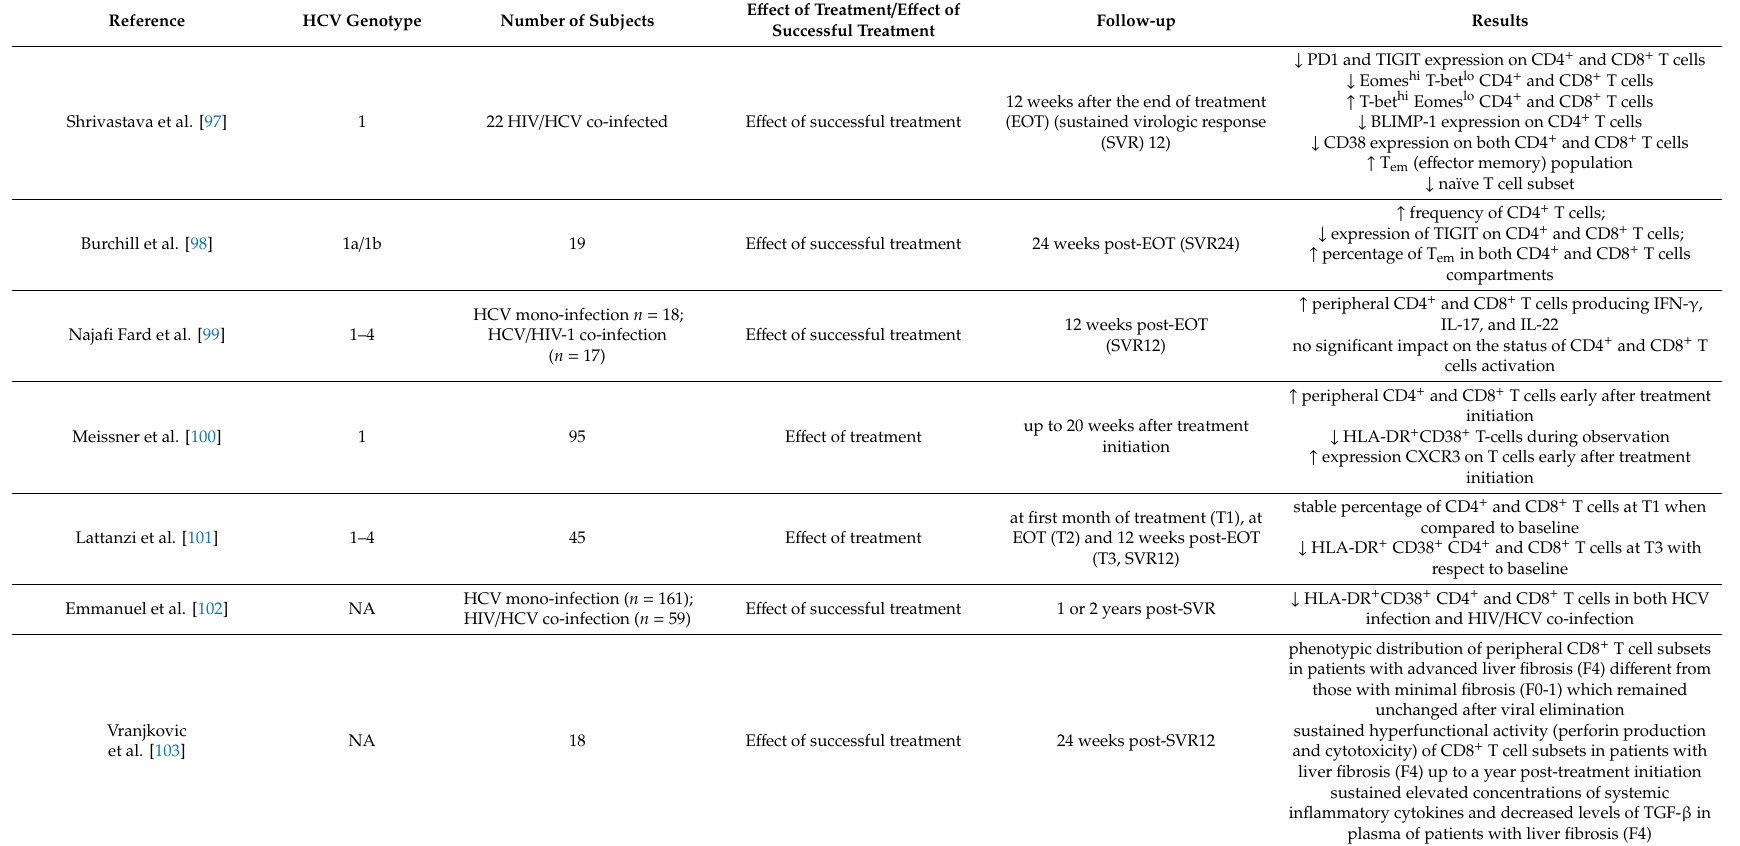
Table 2. Studies reporting the e ff ect of direct-acting antiviral (DAA) treatment on peripheral T cell phenotype or function in chronic HCV infection.